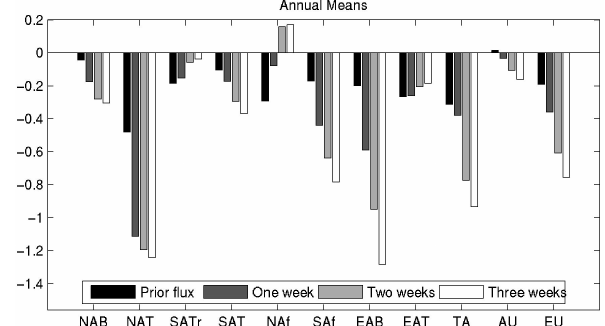
Figure 3. χ 2 statistics of the analysis state for four estimates of error covariance. Original refers to the case without inflations, one Inf refers to the case with inflation on forecast error covariance only, both Inf refers to the case with inflations on both forecast and ob- servation error covariances and iteration refers to the case with both inflations and further using analysis to improve forecast error statis- tics. The closer χ 2 /n obs is to 1, the better the corresponding error estimates.